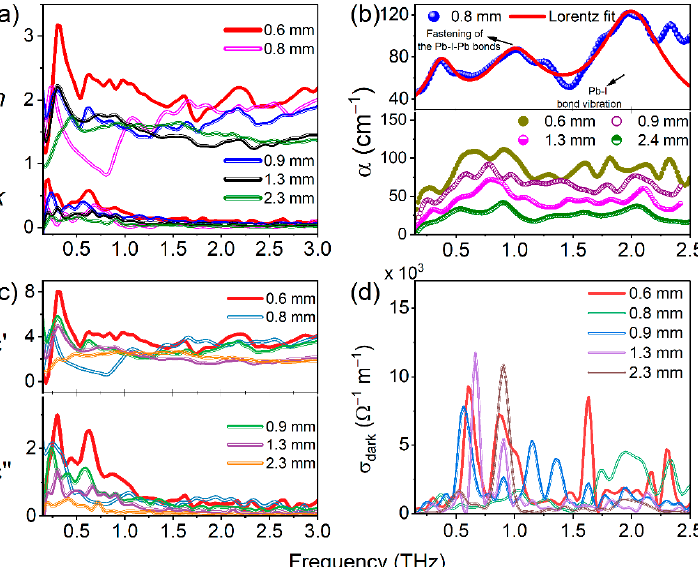
Figure 11. ( a ) Real refractive index (n), imaginary refractive index (k); ( b ) absorption coefficient ( α ), upper panel solid line represents Lorentz peak fit for 0.8 mm MAPbI 3 experimental α data; ( c ) real dielectric constant ( ε ’), imaginary dielectric constant ( ε ”); and ( d ) dark conductivity of various thick- ness MAPbI 3 PSCs measured based on THZ-TDS. In the case of both PSCs, the real parts of the refractive index and dielectric constants are higher than the imaginary parts. The curve shapes of real dielectric constants (Figures 10c and 11c) are very similar to the real parts of the refractive indices (Figures 10a and